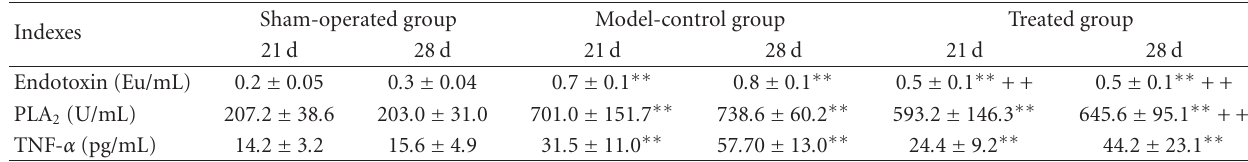
Table 1: Comparison of endotoxin, PLA 2 , and TNF- α